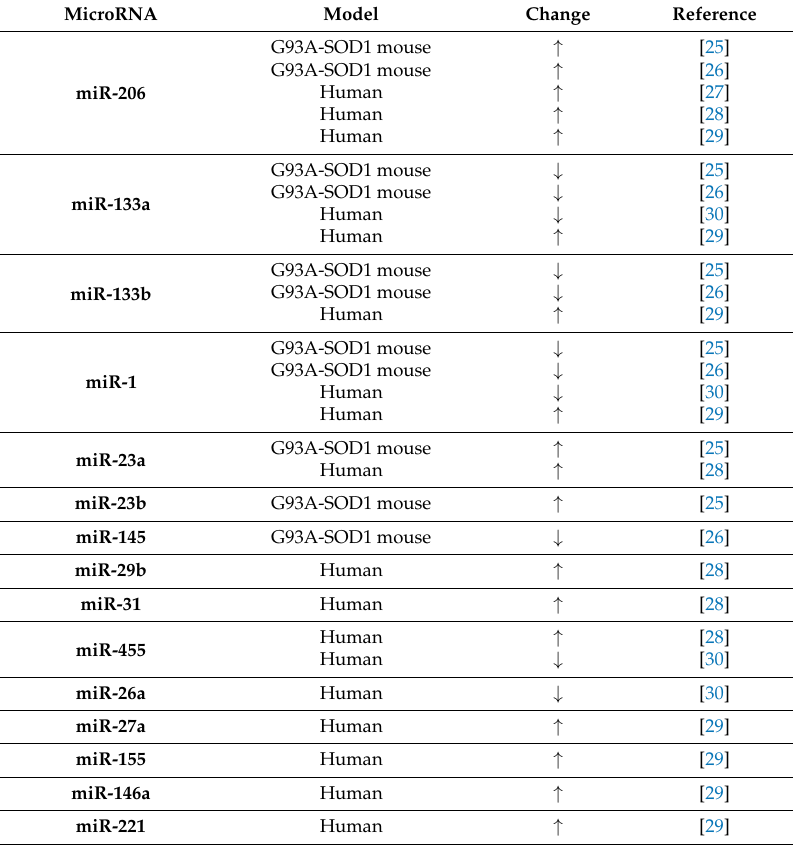
Table 1. Dysregulated microRNAs in amyotrophic lateral sclerosis (ALS) skeletal